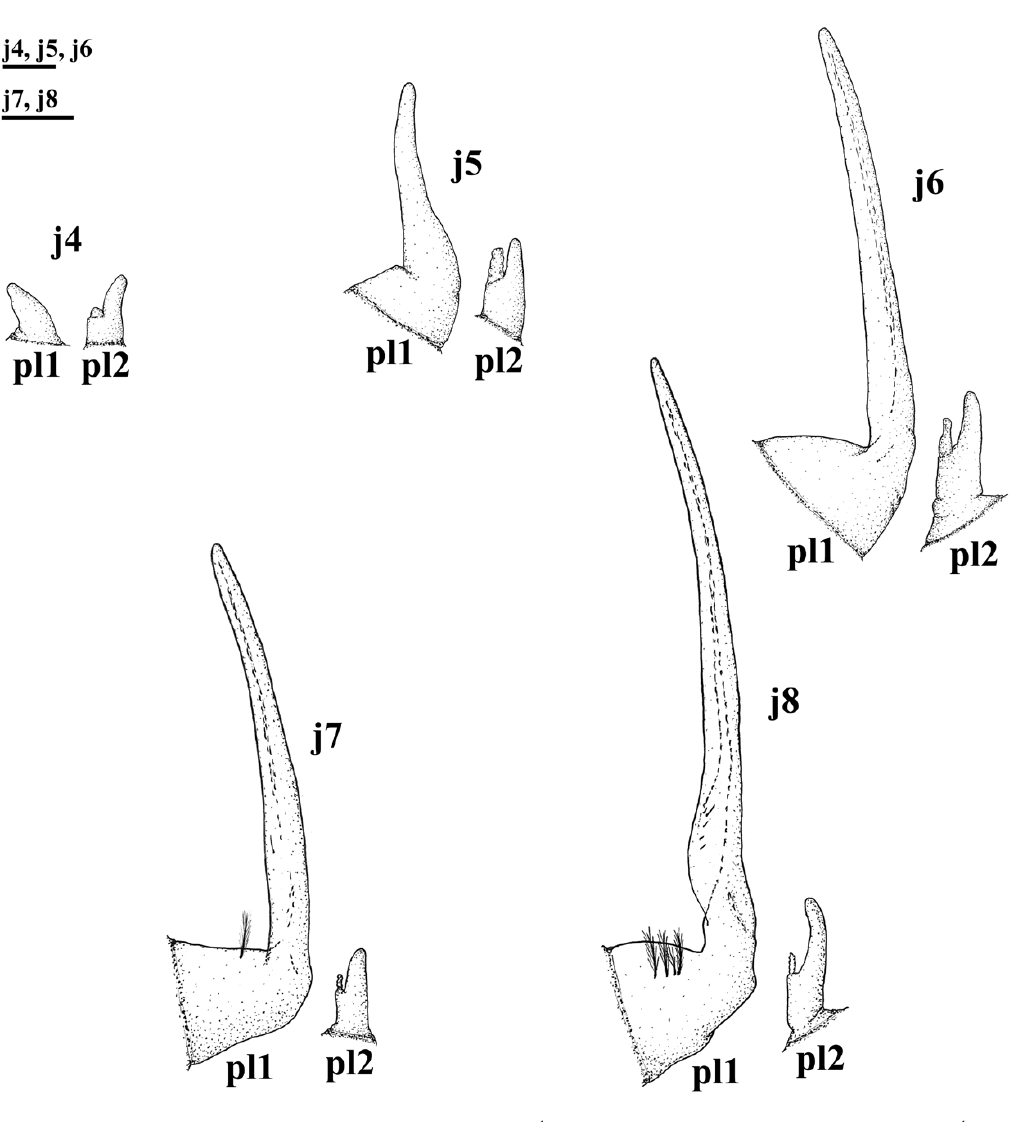
Figure 6 - Callinectes danae . pl1 and pl2 : pleopods of the 1 st and 2 nd male abdominal somites, respectively, from 4 th ( j4 ), 5 th ( j5 ), 6 th ( j6 ), 7 th ( j7 ) and 8 th ( j8 ) stages on. Scale: j4 , j5 and j6 , 0.1mm; j7 and j8 ,